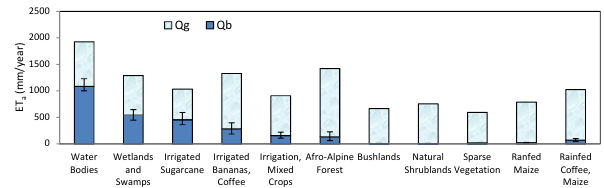
Figure 9. ET a and the corresponding Q g and Q b water use for se- lected land use types averaged per year over 2008–2010 in the upper Pangani River basin (error bar indicates the upper and lower bounds for mean Q b for dry year 2009 and wet year 2008,